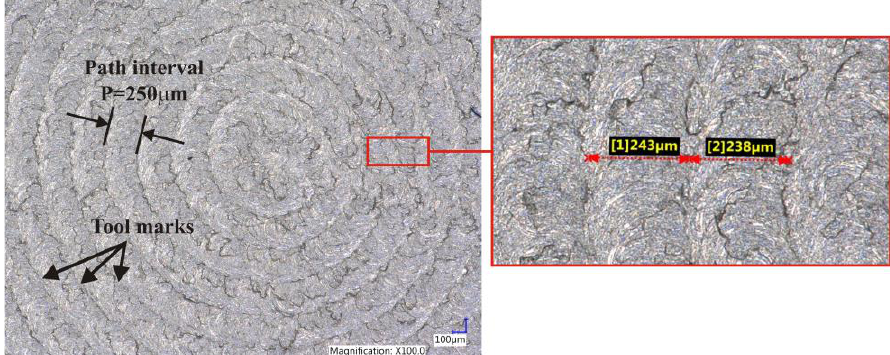
Figure 30. Tool marks and the measured path interval in THE circular-pocket strategy.